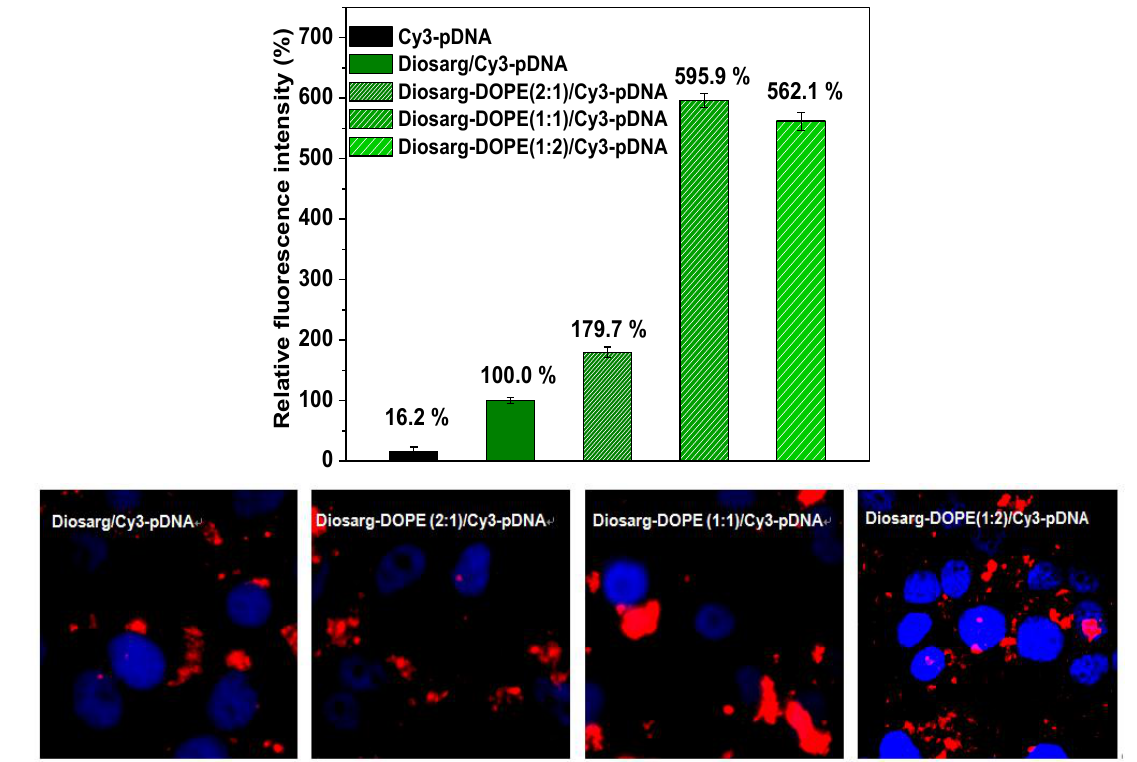
Figure 6. Intracellular uptake of the Diosarg lipid and Diosarg-DOPE (2:1, 1:1, 1:2)/Cy3-pDNA complexes (+/− = 10) in H1299 cells measured by flow cytometry (10,000 cells for each sample) and observed by fluorescence microscopy (blue: DAPI stained nuclei; red: Cy3-labeled pDNA).